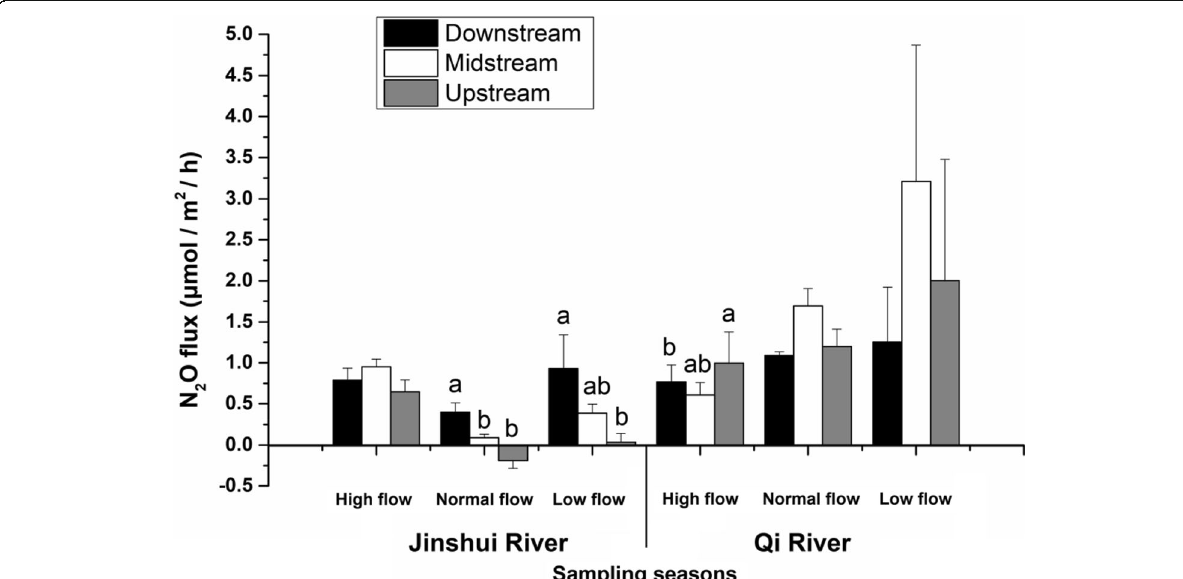
Fig. 4 N 2 O flux in the Jinshui River and Qi River. Vertical bar denote SE of triplicate samples. Different letters indicate significant differences among sampling areas by linear mixed modeling ( P <